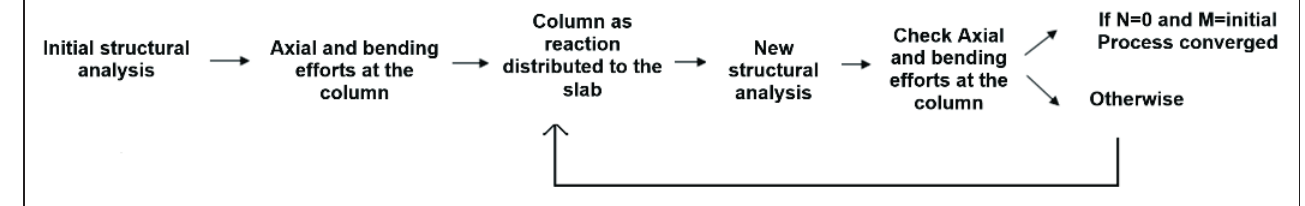
Figure 11 – Method scheme simulating the column as reaction to the slab (PUEL [7])